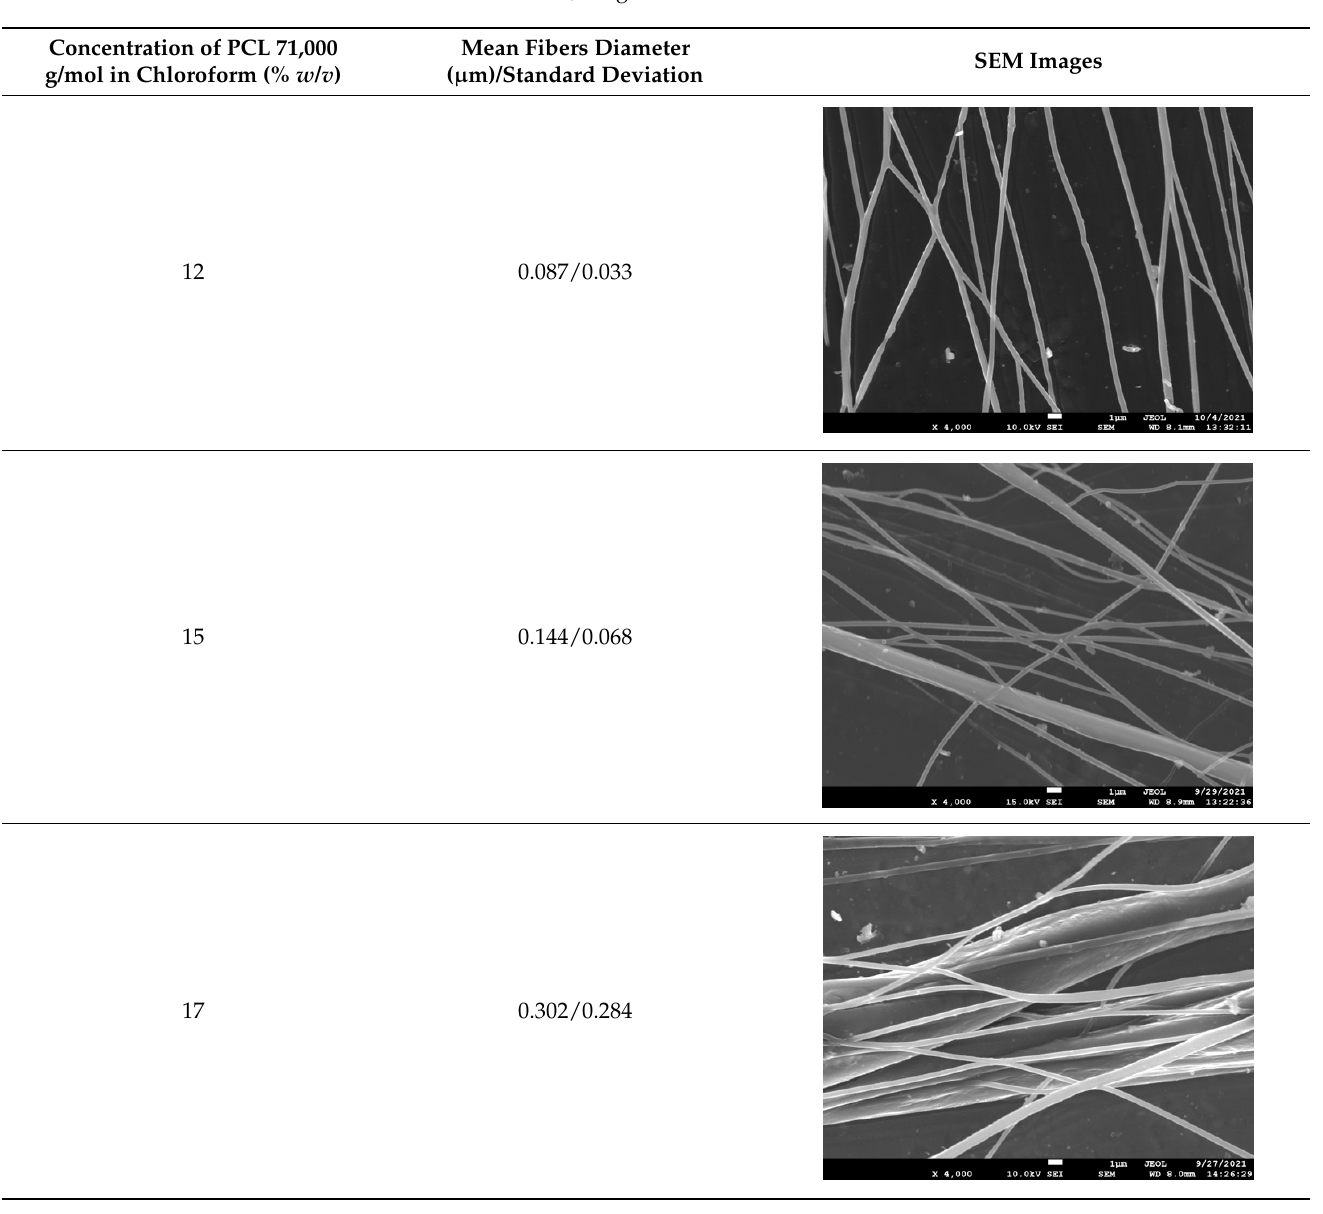
Table 4. SEM images presenting the effect of concentration of the polymer solution on the electrospun structure of PCL with 71,000 g/mol.